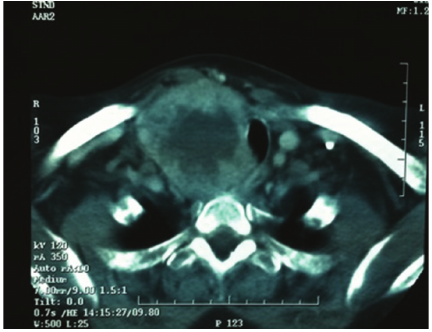
Figure 2: CT scan showing the mass pushing the trachea and occluding its